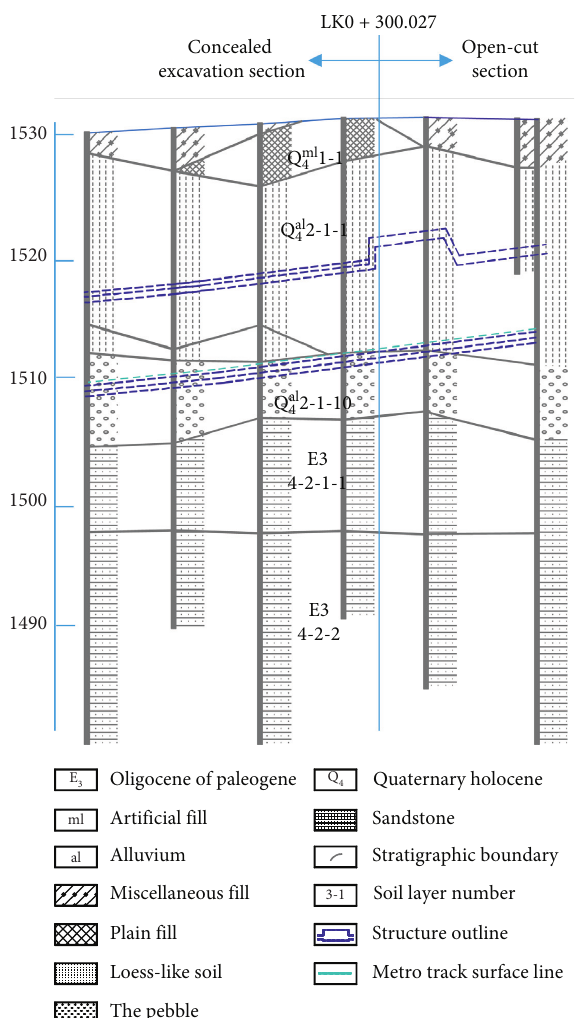
Figure 2: Geological longitudinal profile of the access line of Paihong South Road parking lot.